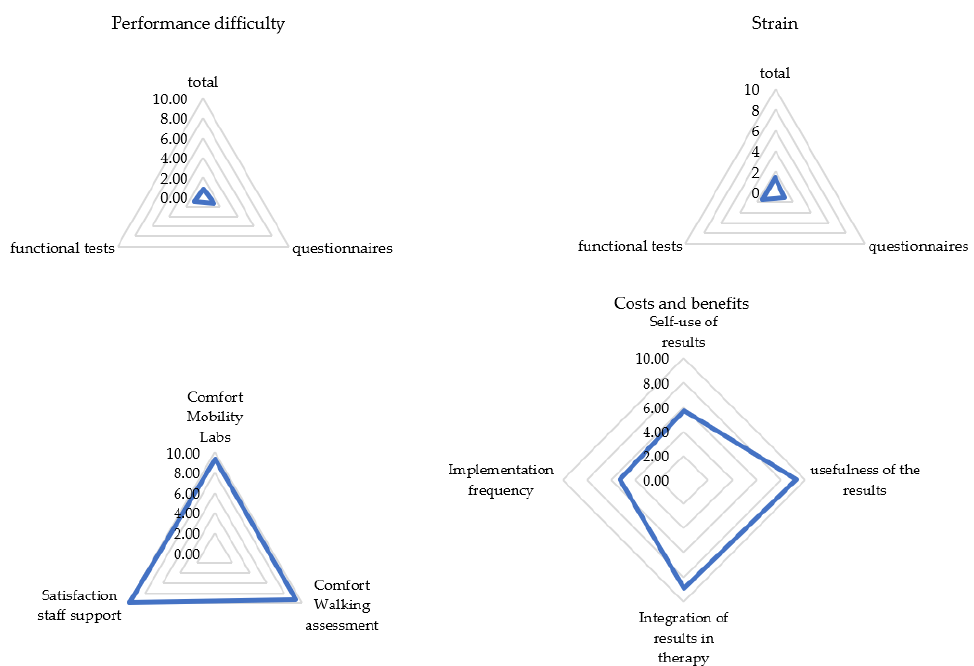
Figure 1. Patient rating for each subcategory ( N = 105). Categories were rated on a scale from 0 (not at all) to 10 (extremely). Presented are mean values of the categories.